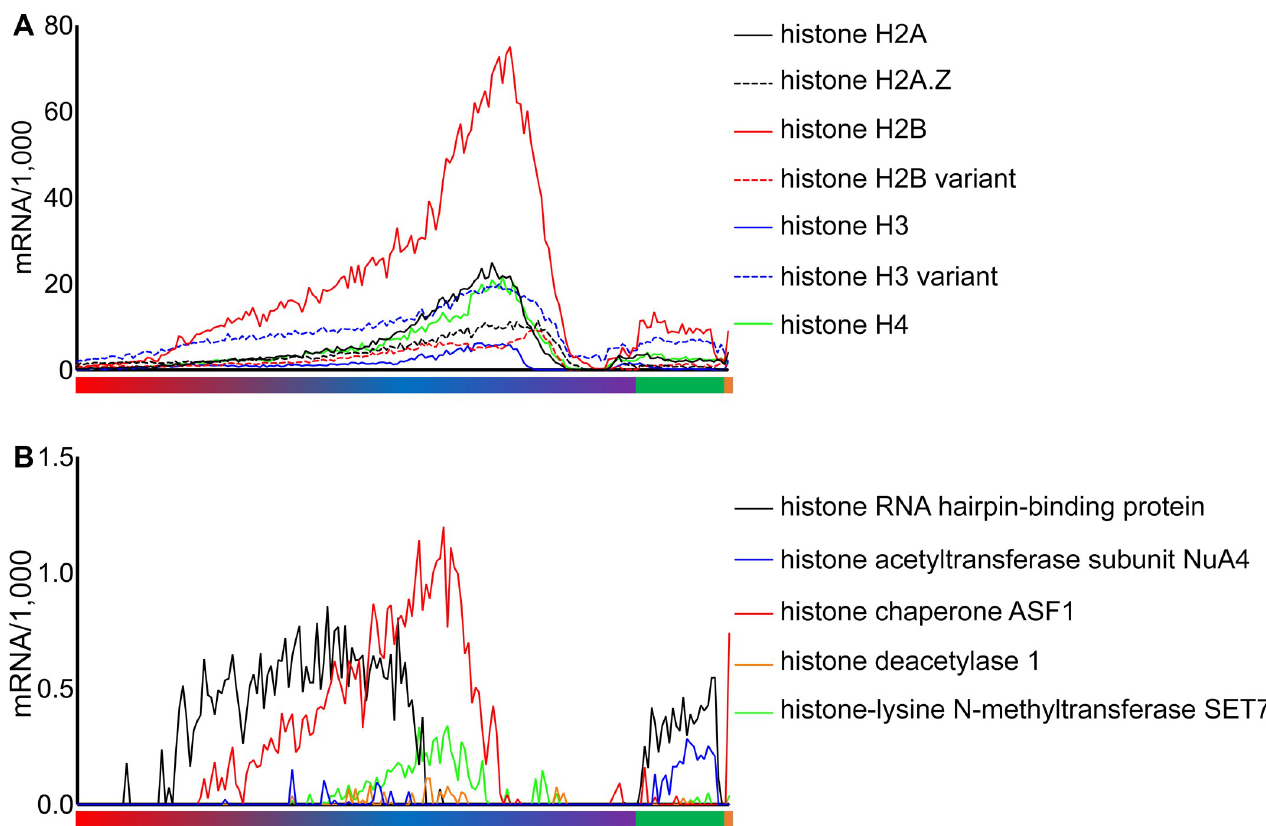
Fig 4. Expression of histone and histone-related genes. (A) Expression of histone genes according to the P . vivax development. The core histones are indicated by solid lines, and the histone variants are shown with dashed lines. Note that the expression level of core histones peaks in early schizonts, consistent with the timing of DNA replication and the need for new nucleosomes. (B) Expression of the 4 detectable histone-related genes according to the parasite development. Note how the histone RNA hairpin-binding protein (PVP01_1014900, in black) expression increases before replication, consistent with its role in nucleosome disassembly and reassembly, whereas ASF1 (PVP01_1442700, in red) peaks slightly before the increase in core histone, consistent with its role in histone mRNA regulation. The color bars under the graphs show the assignment of the parasites to different morphological stages (red, trophozoites; blue and purple, schizonts; green, female gametocytes; orange, male gametocytes). Underlying data plotted in panels A and B are provided in S4 Data.